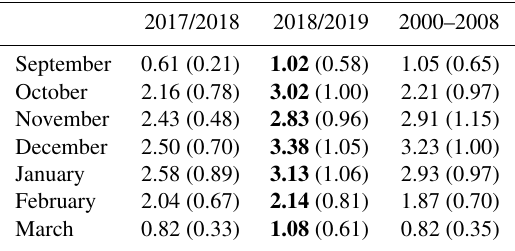
Table 2. Monthly averages of daily erythemal doses (kJm − 2 ) from September to March with SD (in brackets) for the seasons 2017/2018 and 2018/2019. Higher values in each month are in bold. For September 2017, 13d were available, for the rest of the months at least 25d were included. For comparison, monthly averages with SD for the years 2000–2008 are included in the third column and discussed in Sect.